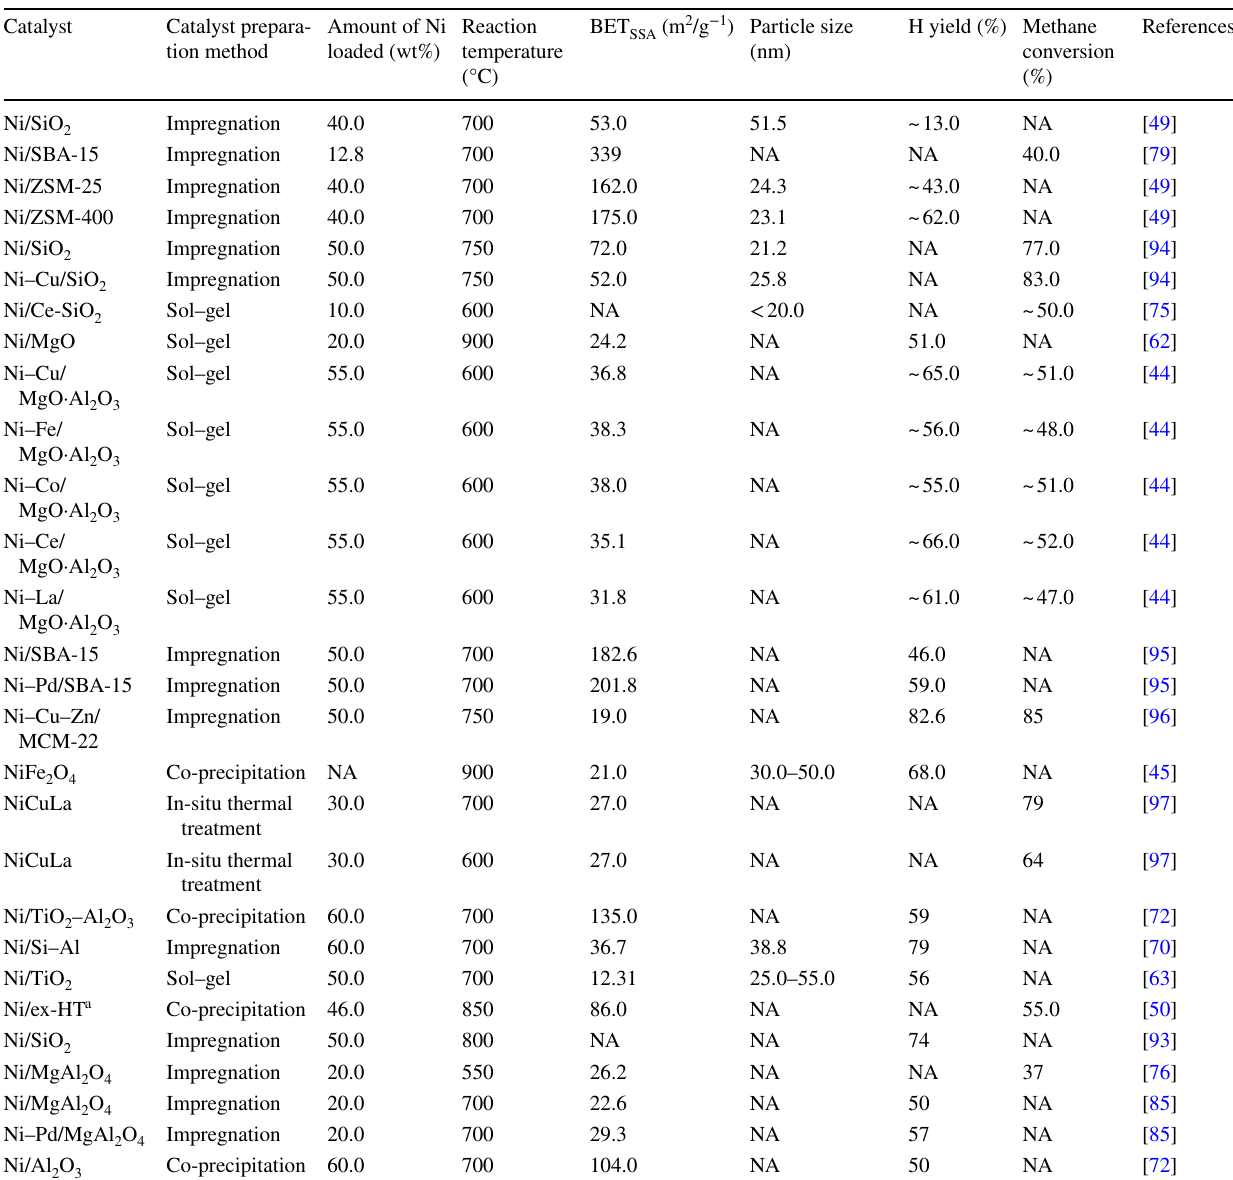
Table 1 Summary of Ni-based heterogeneous catalysts in methane